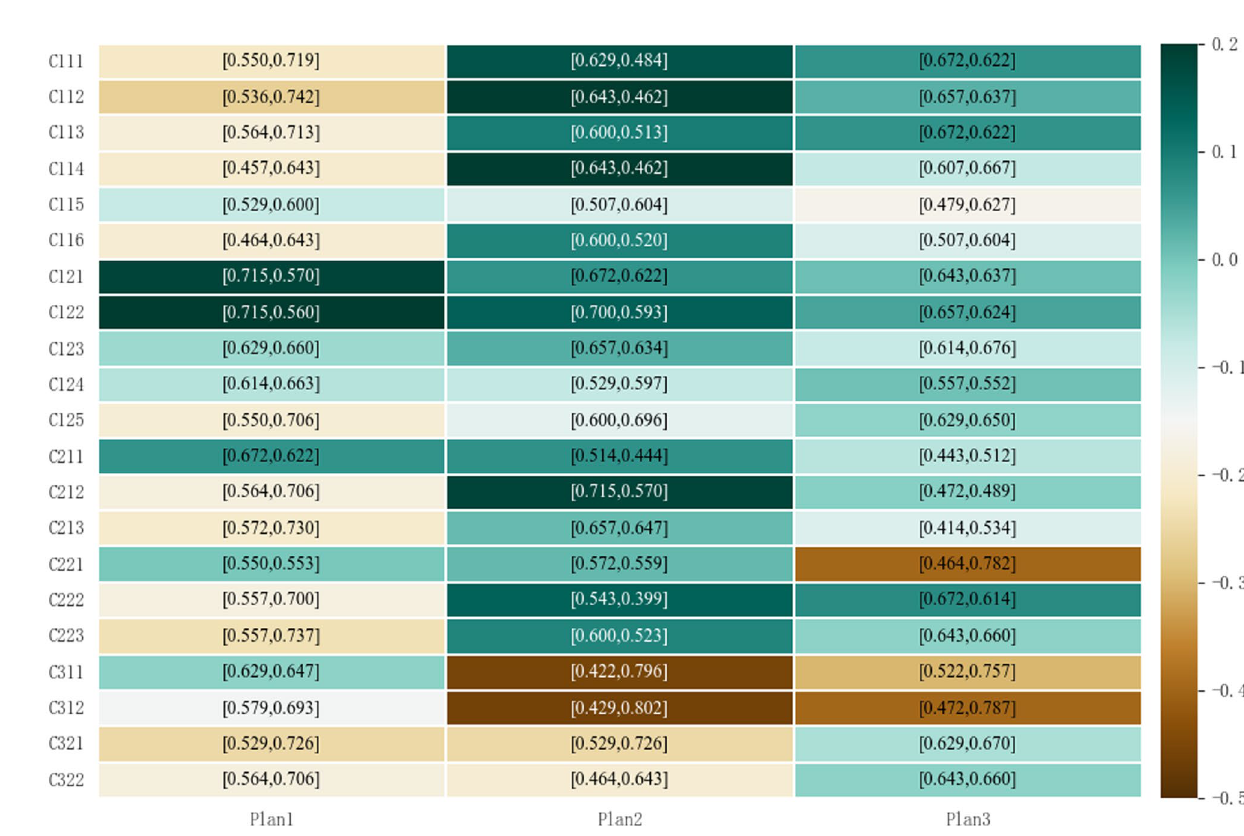
Figure 6. Decision matrix for three design concept